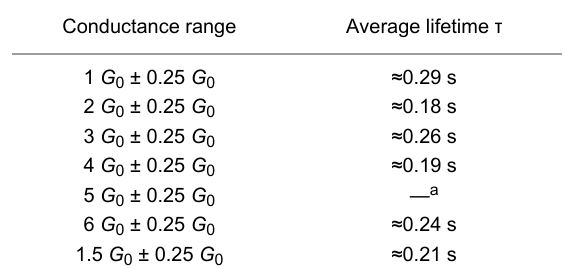
Table 1: Average lifetimes τ of contacts from different conductance ranges as derived from the data shown in Figure 2.